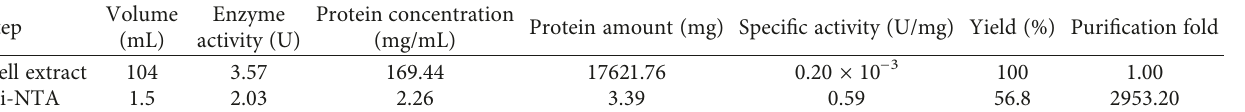
Table 1: Purification of the Bt α GTase enzyme.